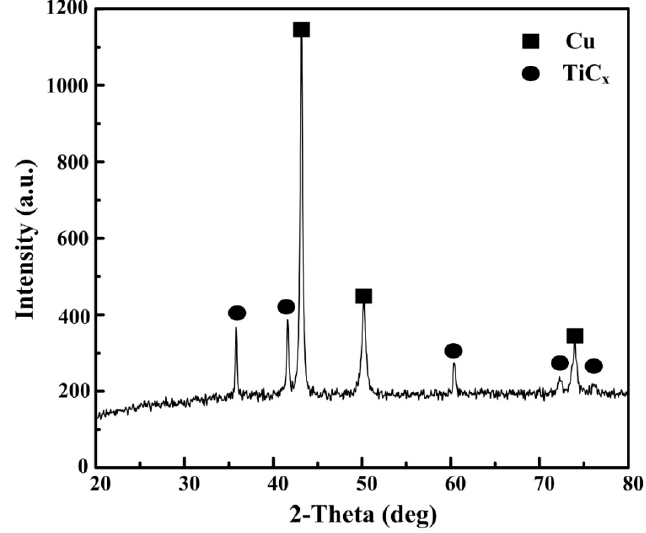
Figure 1. XRD patterns of Cu–Ti–CNTs master alloy after combustion synthesis.